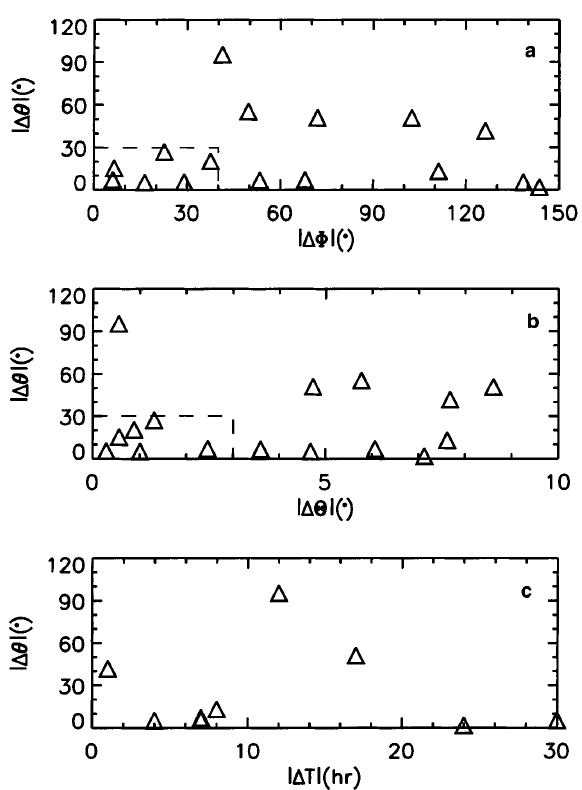
Fig. 3. Scatterplots showing normal’s di(cid:128)erences ( Dh ) versus ( a ) longitude di(cid:128)erence ( DU ), ( b ) latitude di(cid:128)erence ( DH ), ( c ) time lag ( D T ). Note that there are six triangles gathering at both the lower left corners of a and b , which are enclosed by dashed